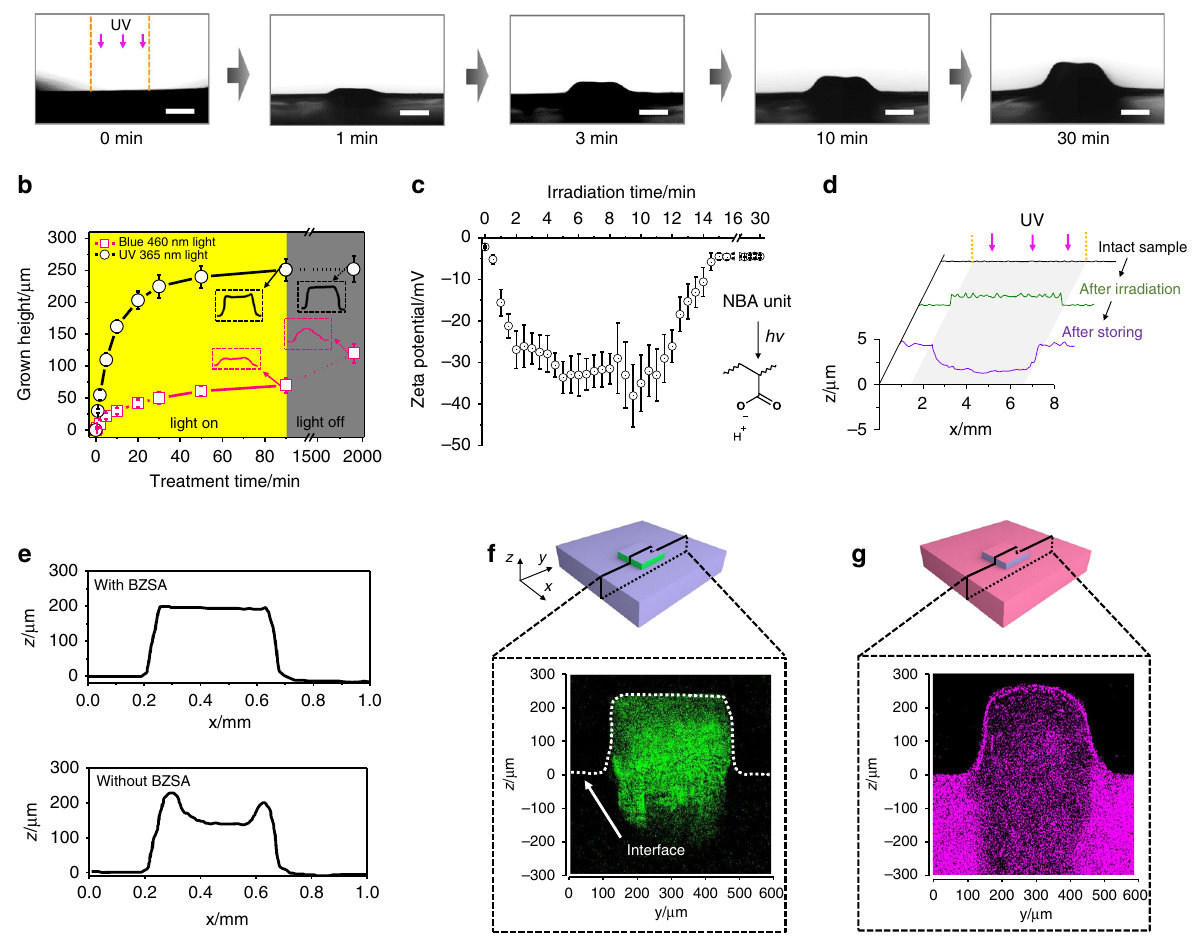
Fig. 2 Light-regulated growth from HBA-based substrates. a Time-dependent images (side view) of swollen substrates under UV irradiation (10mWcm − 2 ). A photomask with a diameter of 500 µ m was used. The scale bar is 250 µ m. b The height of the grown microstructures (grown height) of different samples vs treatment time. The data were obtained from three independent measurements. Error bars are s.e.m. The dashed boxes show the typical pro fi les of the grown structures before and after being stored in the dark. c Zeta potential of linear poly(HBA- co -NBA) copolymers at different irradiation times. The polymer concentration was 2mgmL − 1 , and an LED lamp (10mWcm − 2 ) was used for irradiation. The inset shows the photolytic reaction of the NBA units. d Pro fi les of a swollen seed-20% containing HB acetate, I-819, and BZSA under different conditions. Photomasks with a diameter of 5mm were used. e Typical pro fi les of the grown structures obtained from the swollen seed with (top) or without (bottom) transesteri fi cation catalyst BZSA. Fluorescent cross-section images of the grown structure obtained from a nondyed seed and dyed nutrient ( f ) and a dyed seed and nondyed nutrient ( g ). The substrates used in ( a ), ( d ), ( e ), ( f ), and ( g ) contain 20% promoter (seed-20%). PDIDA was used to dye the seed in ( f ) and the nutrient in ( g ) with a concentration of